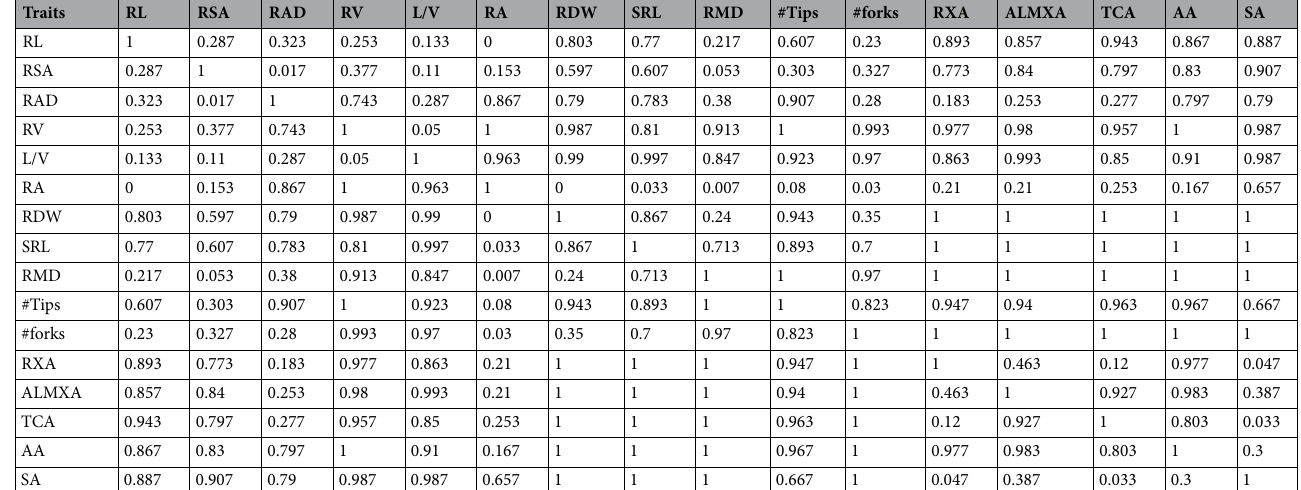
Table 4. Summary of allometric analysis of root-shoot system traits under field condition. The P -values of allometric cross comparison of root morphological, anatomical and shoot traits. P -values < 0.05 indicate a significant allometric relation between the traits calculated by bootstrapping (boot = 300). See Table 1 for traits